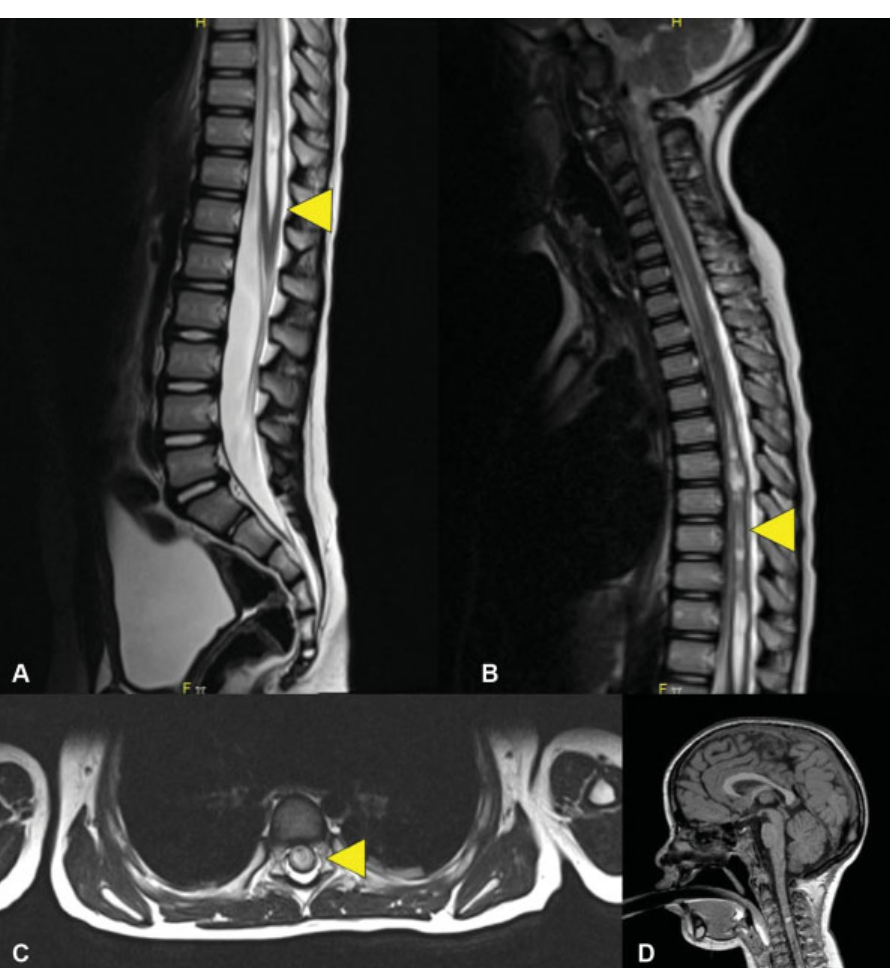
Fig. 1 Sagittal T2-weighted magnetic resonance imagings (MRIs) of the patient showing syringohydromyelia from conus medullaris ( A ) to thoracic spine, ( B ) axial T2-weighted MRI of the syrinx ( C ) and cranial MRI without Chiari 1 malformation ( D